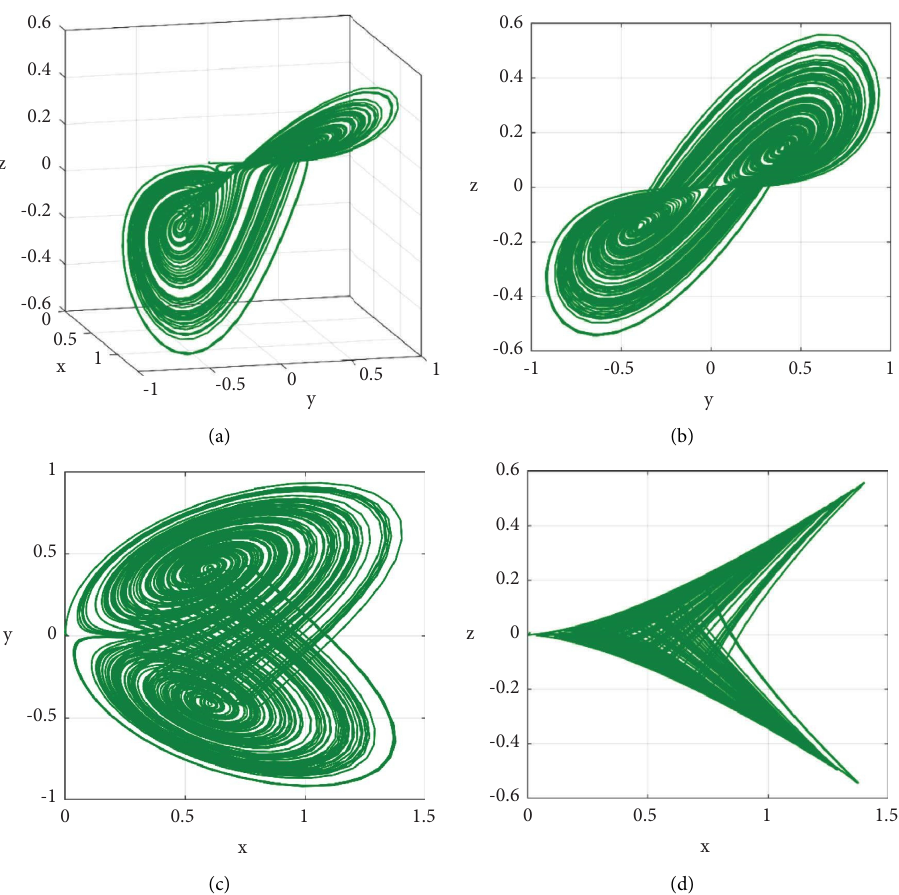
Figure 3: Phase plane trajectories of the system when a � 2 ,b � 7 ,c � 5 , f � 8 , g � 11 , r � 4 and x ( 0 ) � y ( 0 ) � z ( 0 ) � 0 . 01: (a) Tree- dimensional phase trajectory in ( x,y, z ) and (b–d) two-dimensional phase trajectory in ( y, z ), ( x,y ), and ( x,z ),